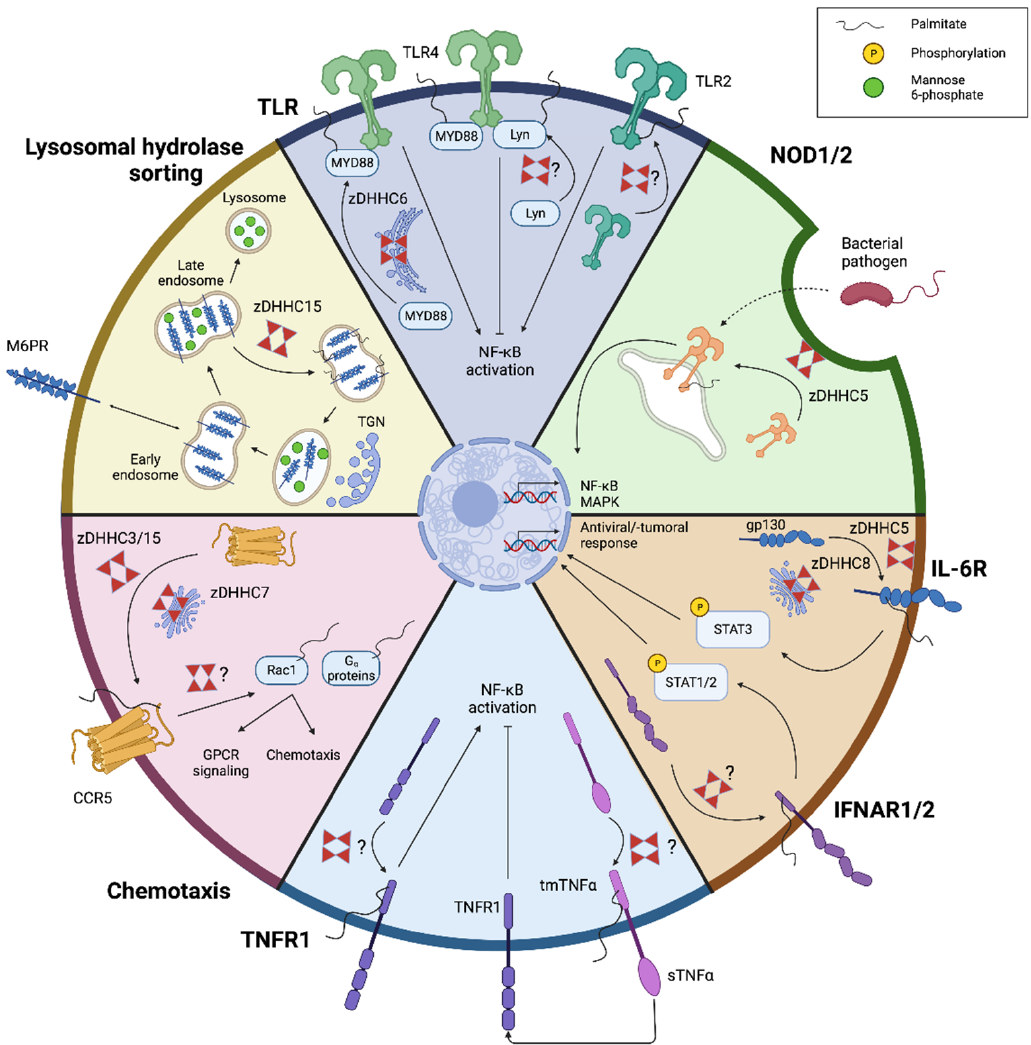
Figure 3. S-palmitoylation regulates lysosomal hydrolase sorting and cytokine, chemokine, NOD, and TLR signaling. First, few studies defined that S-palmitoylation controls TLR4 signaling by af- fecting the activity and binding properties of the adaptor molecule MYD88 and tyrosine kinase Lyn, thereby promoting or inhibiting TLR4 signal transduction, respectively. Moreover, TLR2 membrane distribution as such depends on S-palmitoylation. Second, membrane localization and ability to ac- tivate NF- κ B and MAPK of NOD1/2 is associated with zDHHC5-mediated S-palmitoylation. Third, diverse cytokine and chemokine receptors expressed by macrophages rely on S-palmitoylation for signal transduction. For instance, zDHHC5/8-mediated palmitoylation of gp130, a subunit of the IL- 6 receptor complex, affects its surface localization and downstream STAT3 phosphorylation. Like-